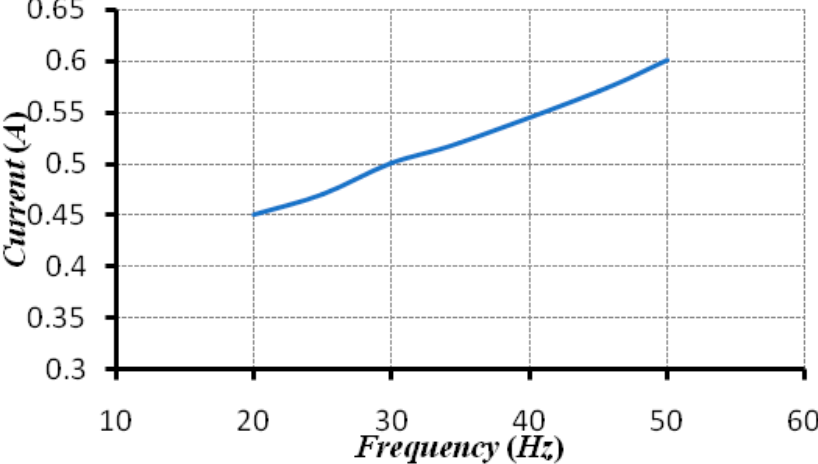
Figure 14. Measured input current against frequency relationship.